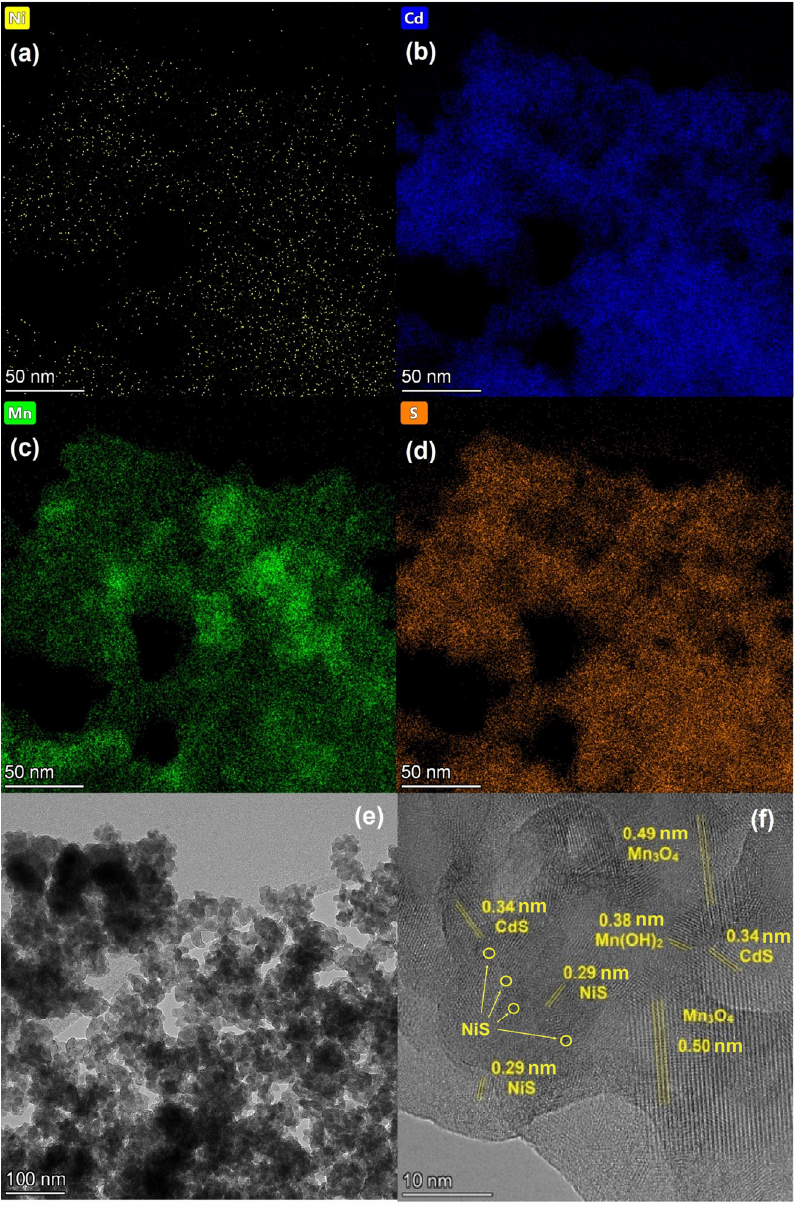
Figure 5. Element mapping ( a – d ) and TEM images ( e , f ) of 0.1% NiS/Mn0.6 HT120 photocatalyst.